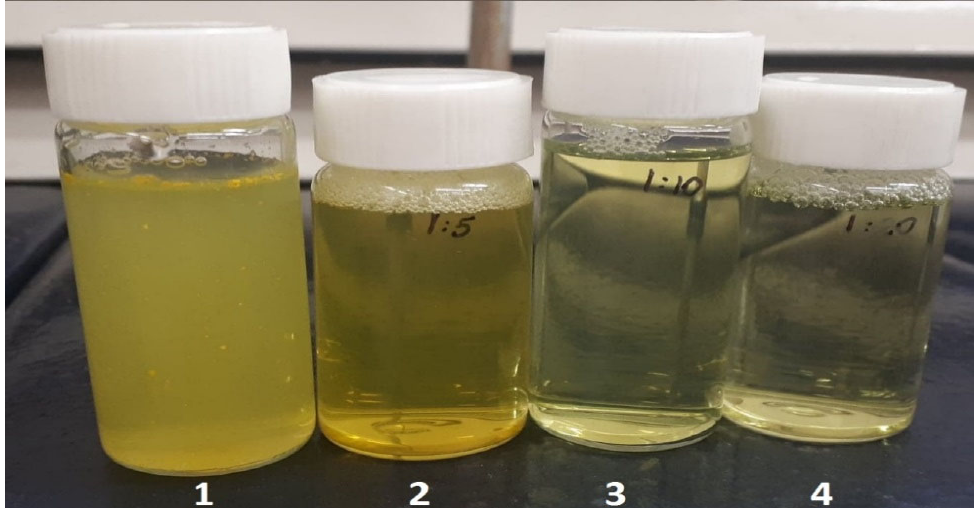
Figure 2. Comparison of the xanthohumol suspension (0.125 mg/mL) ( 1 ), and xanthohumol-loaded micelles solutions in water with various drug to polymer ratios: Pluronic P123 and F127 mixed micelles 1:5 C = 0.75 mg/mL ( 2 ), 1:10 C = 1.375 mg/mL ( 3 ) and 1:20 C = 2.625 mg/mL ( 4 ). Table 1. Results of naringenin-loaded micellar nanoparticles preparation. LE—lyophilisation effi- ciency, DL theor —theoretical drug loading, DL exp —experimental drug loading, EE—encapsulation